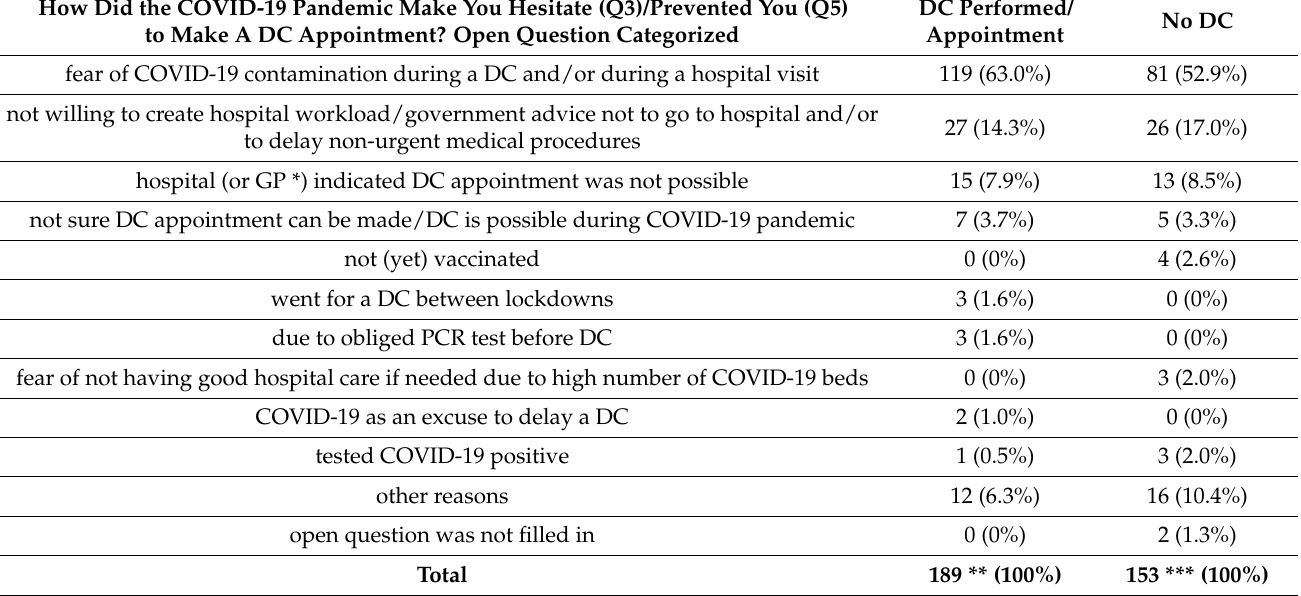
Table 6. Self-reported reasons for hesitancy (group with DC or DC appointment) or non-compliance (no DC group) to plan a